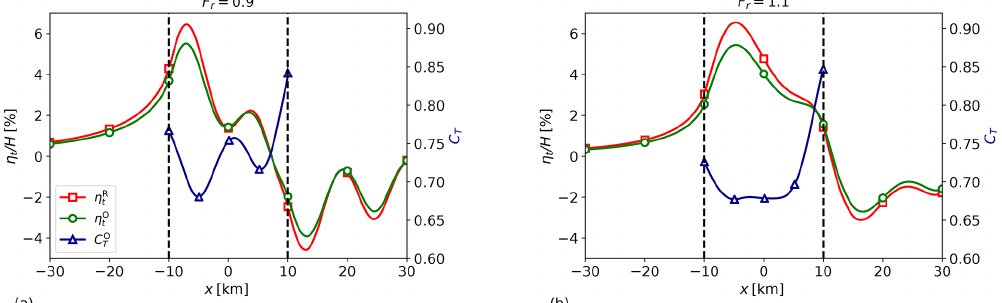
), reference ( η R t ) and optimal ( η O t ) inversion-layer displacement T